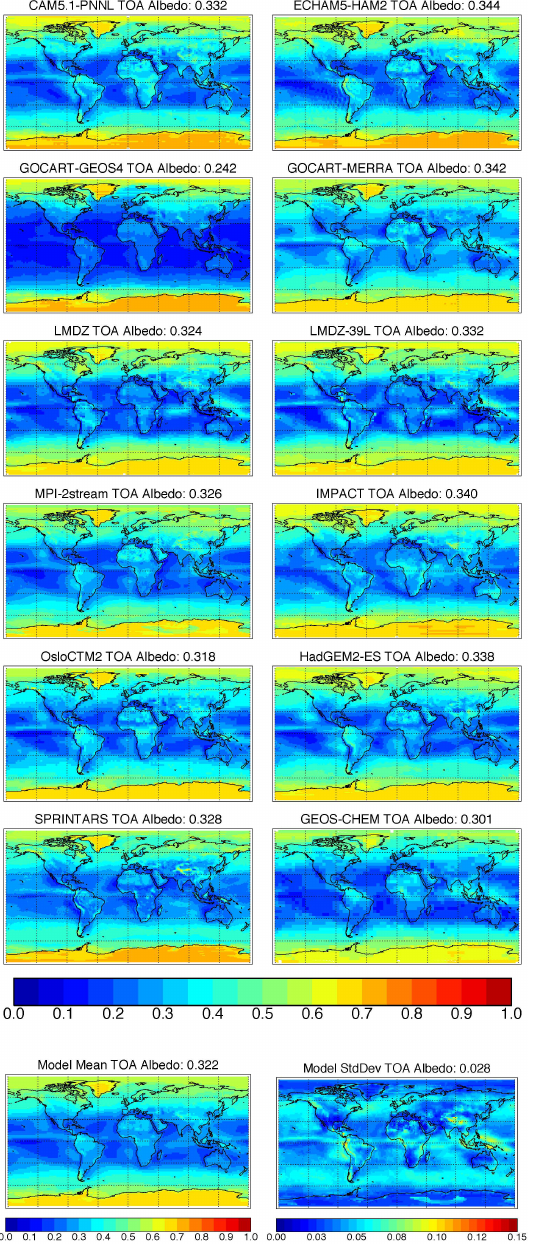
Fig. 4. Annual mean broadband short-wave top-of-atmosphere albe- dos for experiment FIX0 (AOD=0.0).